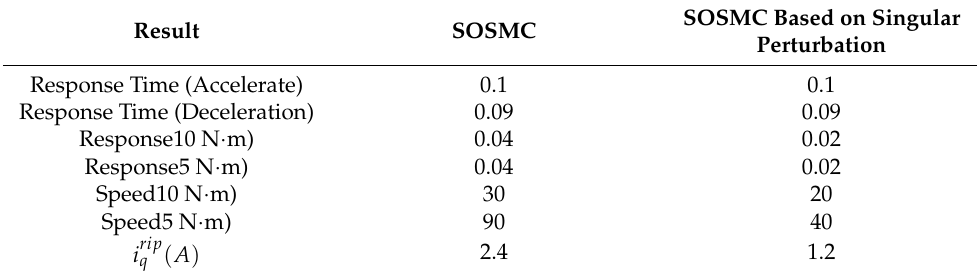
Figure 8. Experimental results of motor speed variation based on second-order sliding mode control with singular perturbation. Table 4. PMSM system